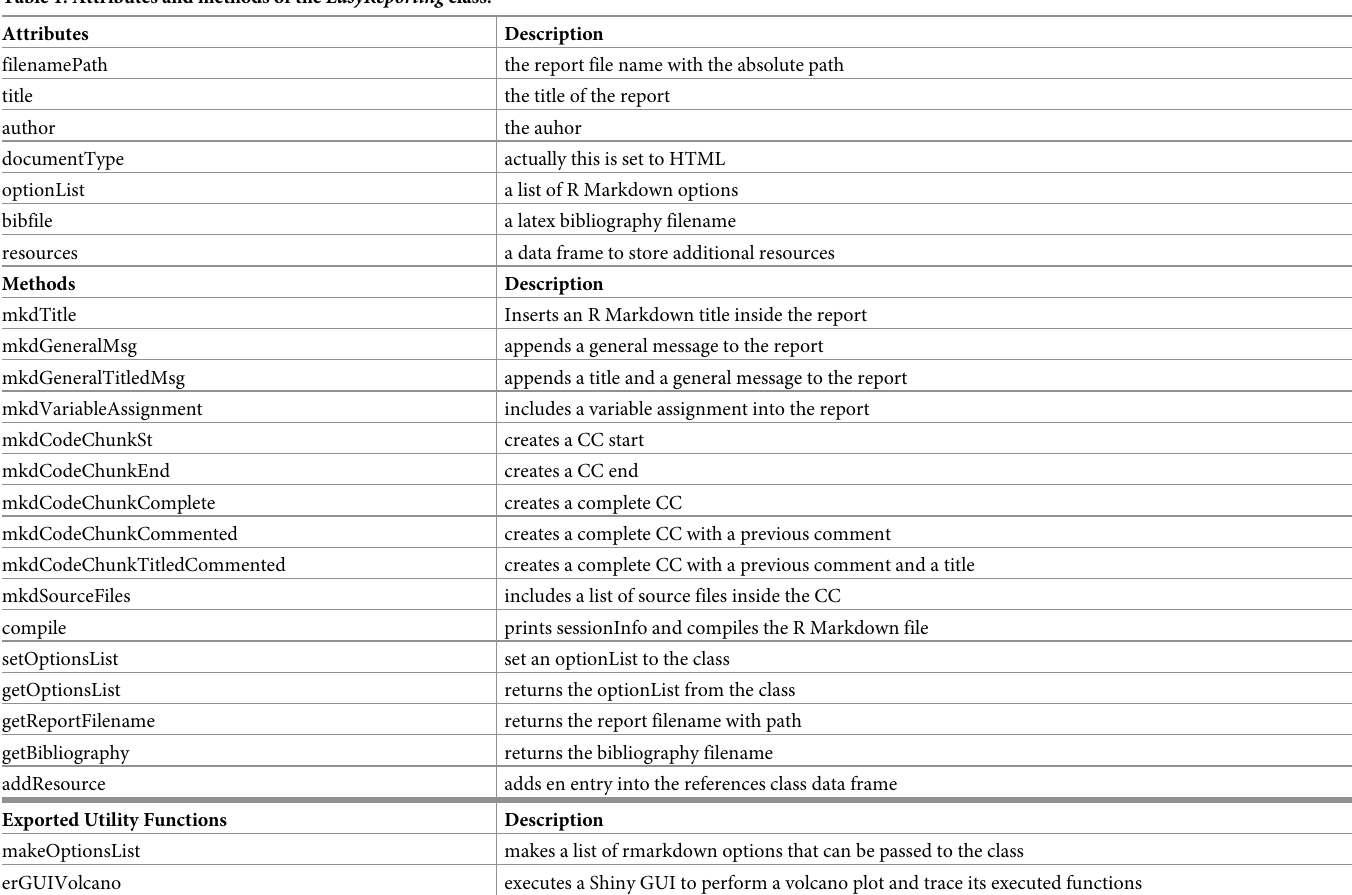
Table 1. Attributes and methods of the EasyReporting